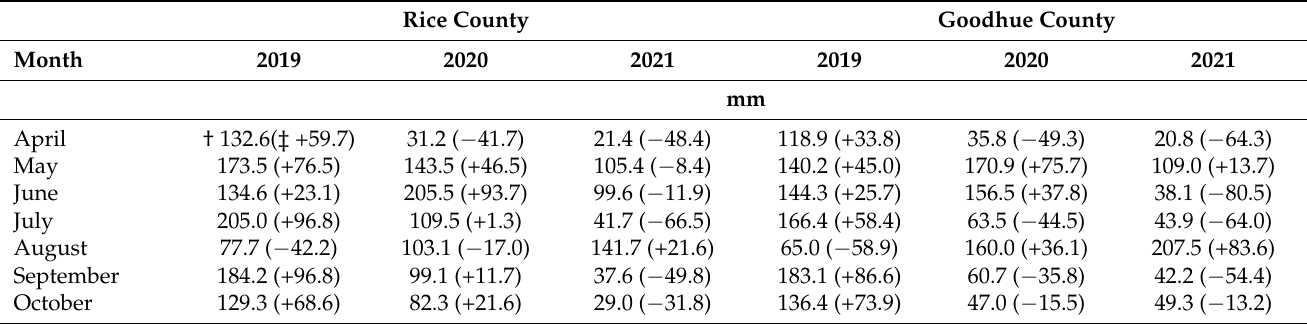
Table 1. Monthly precipitation data and departures from the normal during the 2019, 2020, and 2021 growing seasons at Rice and Goodhue Counties, MN, USA.